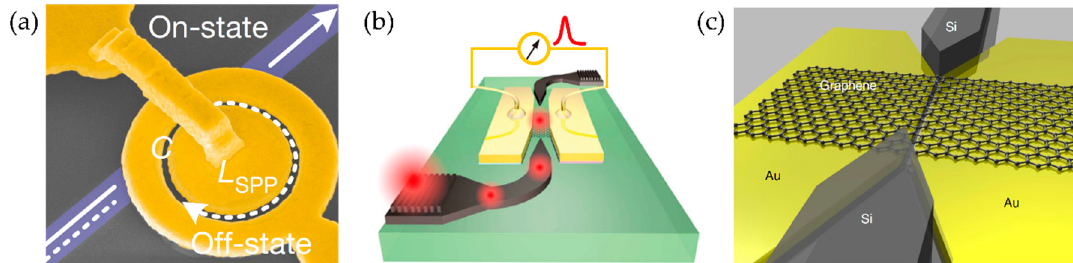
Figure 13. Some latest works of HPPs based on SOI platform. ( a ) A plasmonic electro-optic modulator. ( b ) An integrated graphene plasmonic photodetector. ( c ) A graphene-loaded plasmonic all-optical switch. Figures reproduced from ( a ) [91]; ( b ) [152]; ( c )